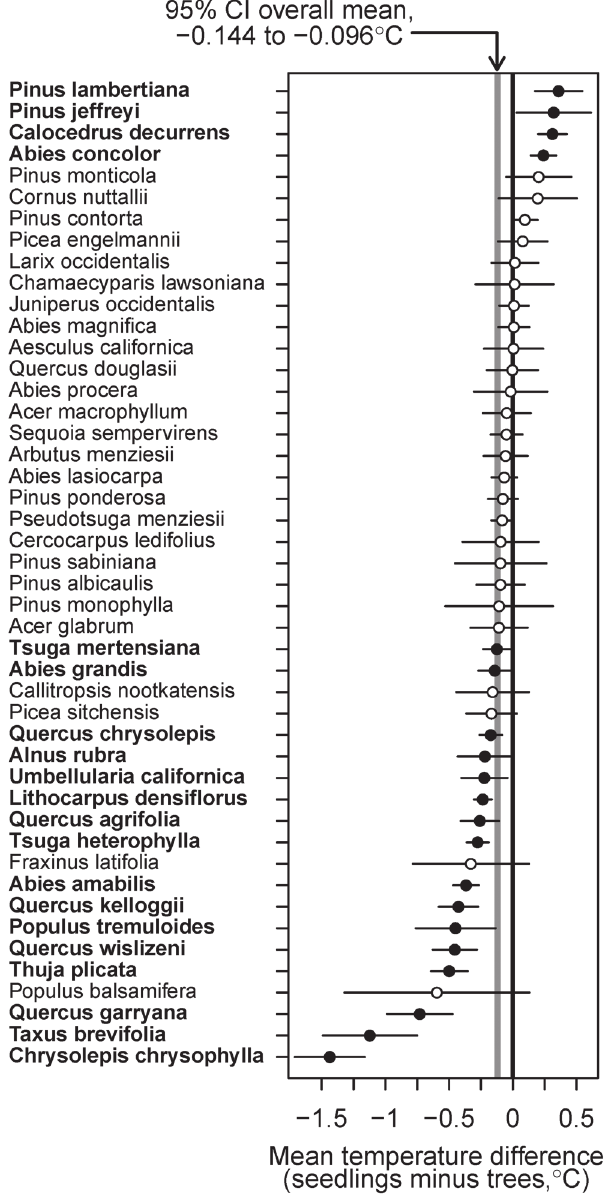
Fig 5. Difference between the mean temperature of the range of seedlings and that of mature trees. A positive number indicates that the mean temperature of the seedling range is warmer than that of trees. The circles represent the estimated difference for each species and the horizontal lines represent 95% confidence intervals for the difference. Solid circles and bold species ’ name indicate that the 95% C.I. does not include 0 (difference significant at the 0.05 level). The gray band is a 95% C.I. for the overall mean difference, across all